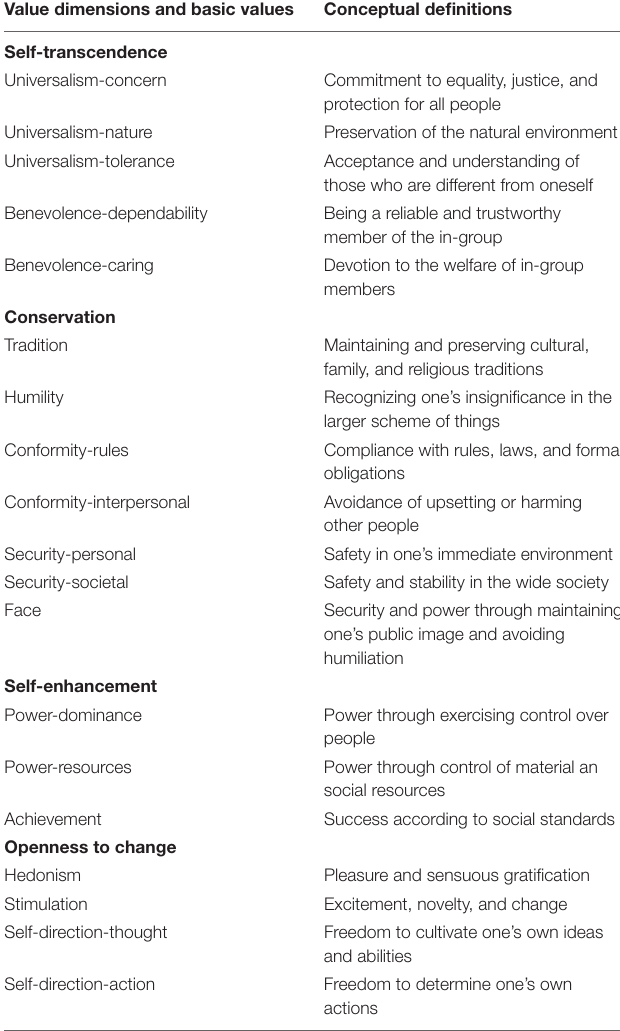
TABLE 1 | The 19 values in the refined theory of values (from Schwartz et al., 2012). Value dimensions and basic